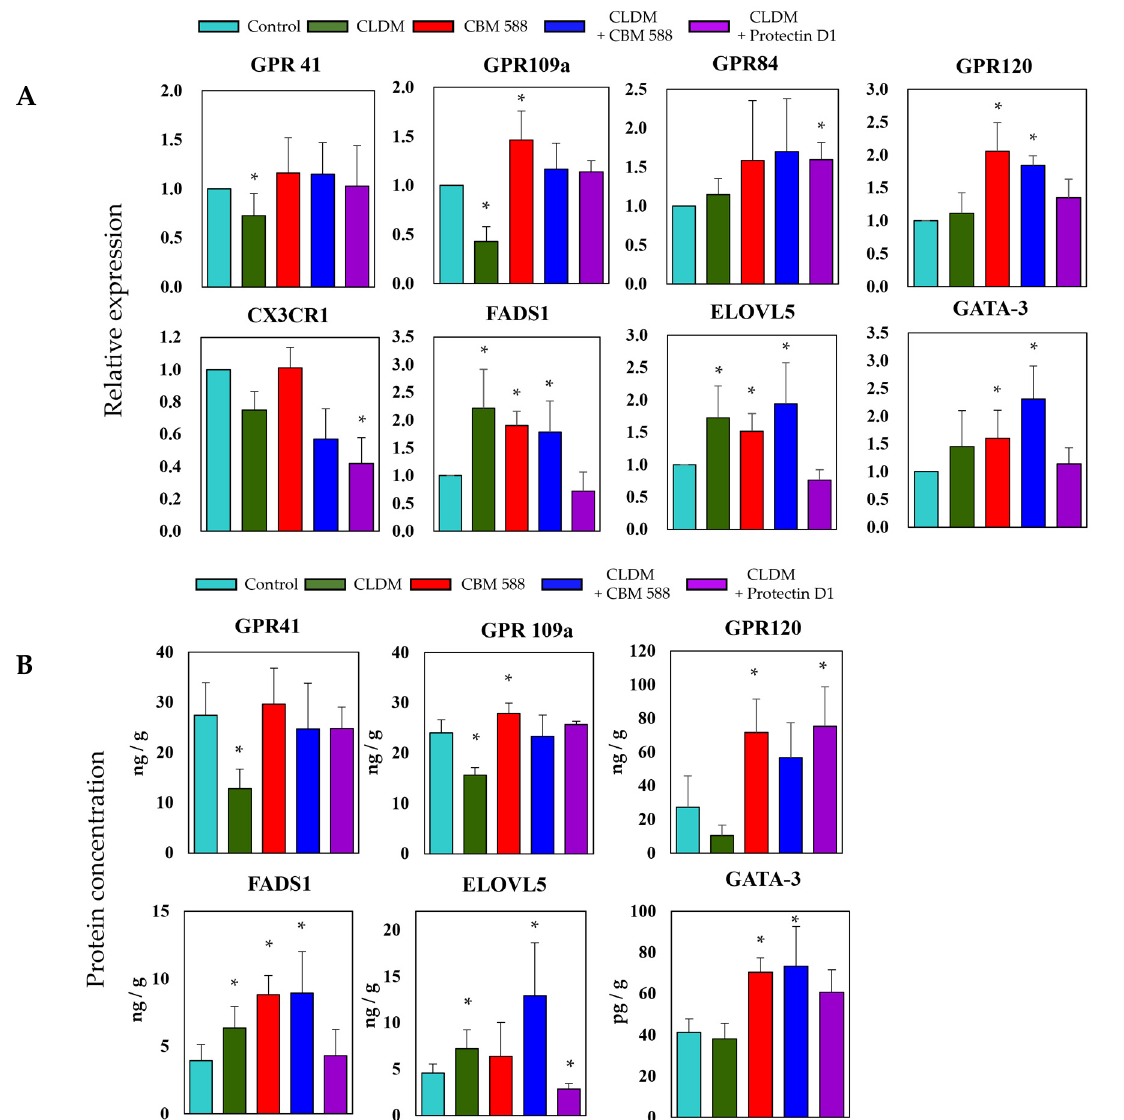
Figure 6. The gut microbe altered by CBM 588 and/or protectin D1 upregulates host fatty acid receptors, lipid elongation enzymes, and immune cell signaling factors. ( A ) Relative RNA levels of genes-encoding enzymes related to fatty acid metabolism and signal factors of immune cells in colon tissue of mice. ( B ) Concentrations of GPR41, GPR109a, GPR120, FADS1, ELOVL5, and GATA-3 in colon tissues of mice. Relative RNA levels of each target gene were normalized to those in the control group (represented as RQ on the vertical axis). Values represent mean ± SD ( n = 5). Statistical significance was set at p < 0.05. * p < 0.05, compared with control.